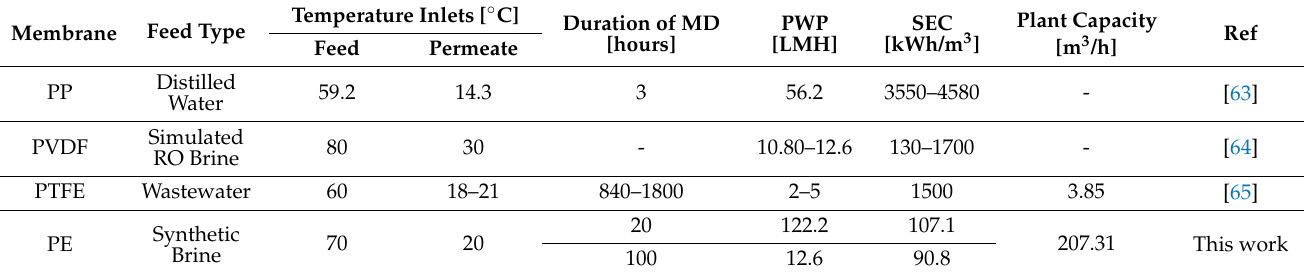
Table 2. PWP and SEC values recorded in previous studies for DCMD systems